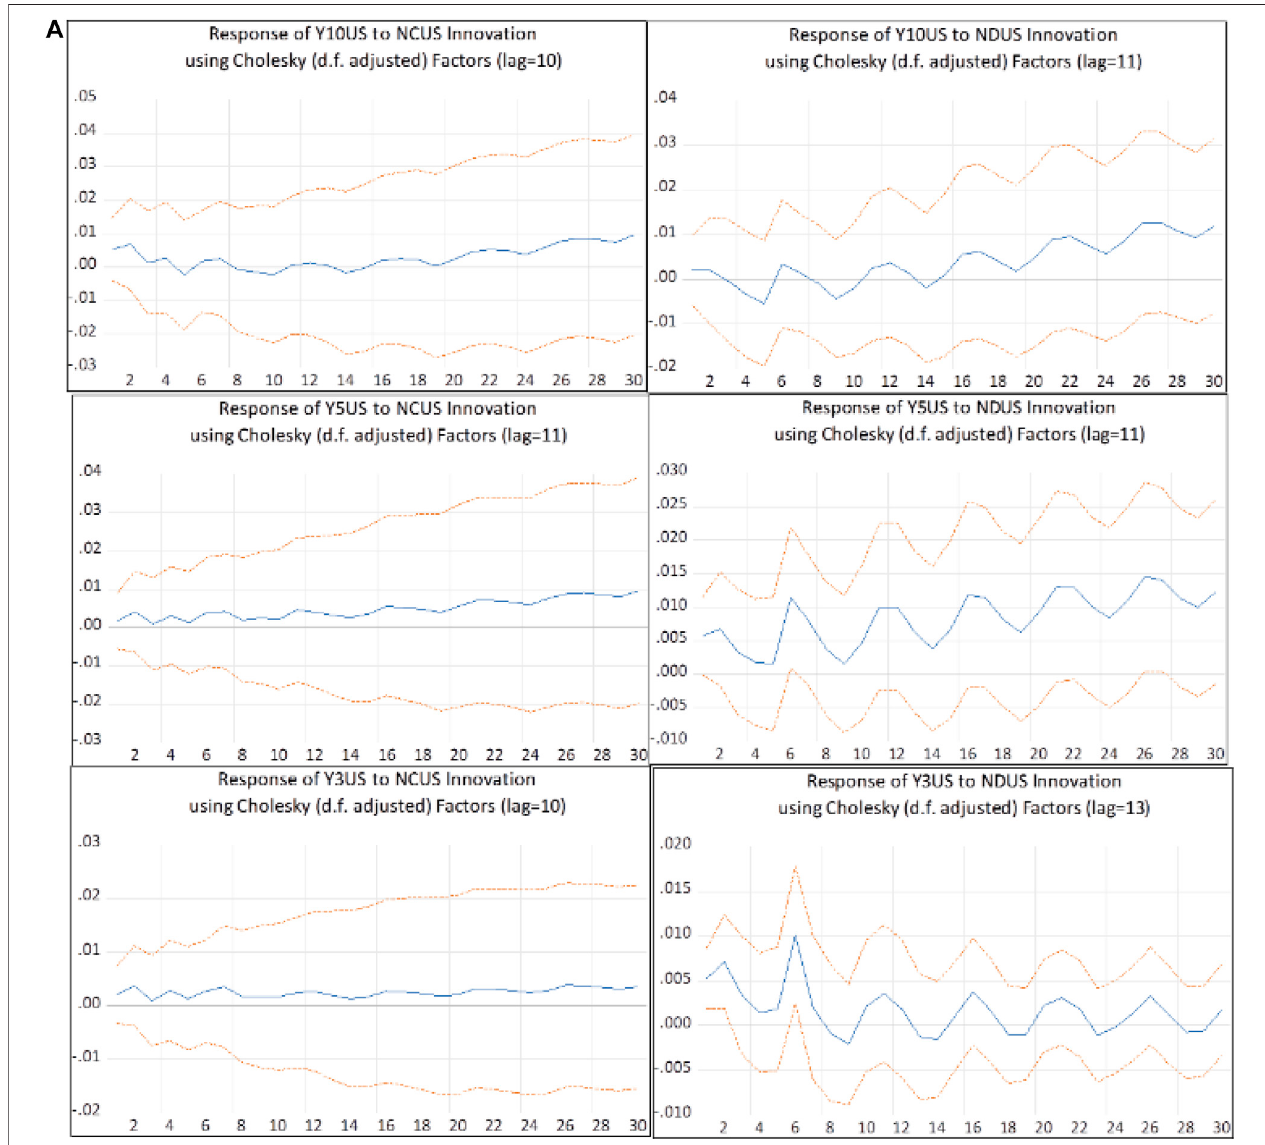
FIGURE5| ResponseoftheUnitedStatesgovernmentbondyieldstothespreadoftheCOVID-19pandemicinthecountryandgloballevel.Note:Theeffectofthe country-level COVID-19 situation can be seen in (A) , while the effect of the global level situation is shown in (B) .